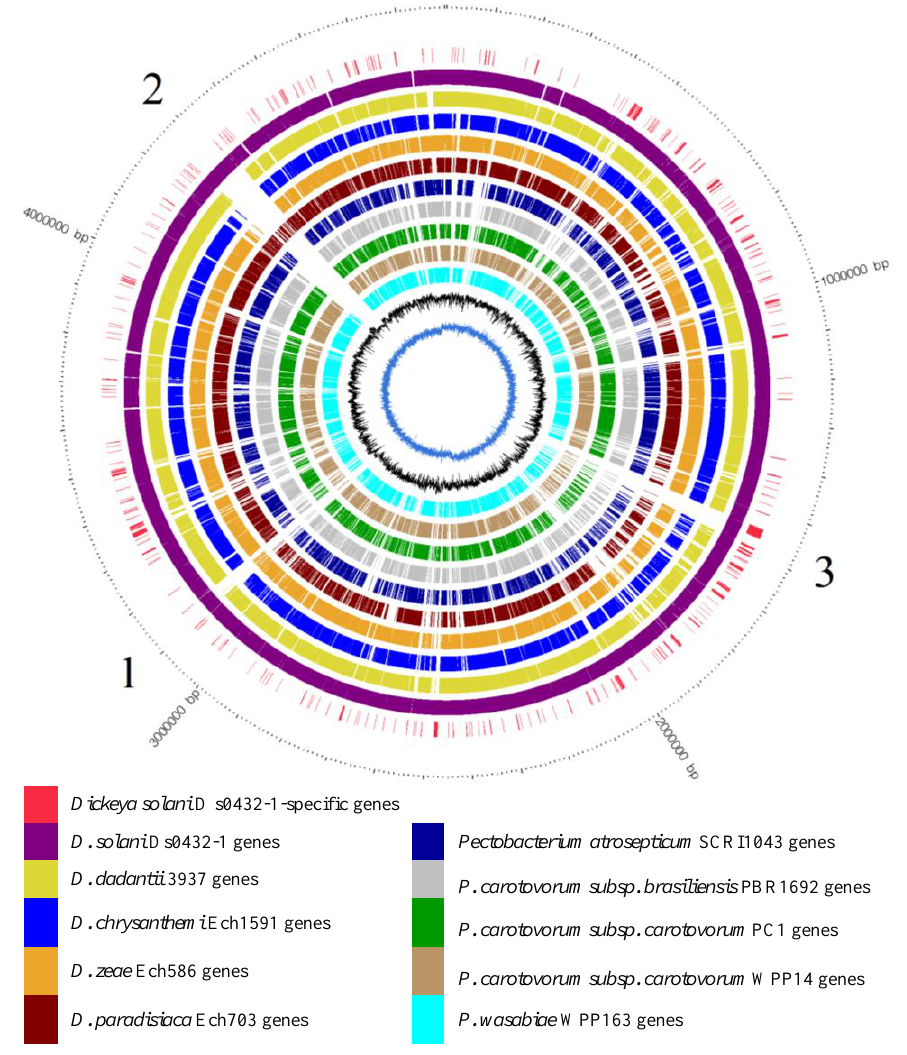
Figure 2. Comparative genomics between Dickeya strains. Comparison of gene coding sequences between D. solani D s0432-1 and other sequenced Dickeya strains reveals three large genomic regions ( 1 , 2 and 3 ) coding for non-ribosomal peptide synthetases and polyketide synthetases (numbered according to the order of description in the results). The tentative D. solani -specific open reading frames are shown as the outermost